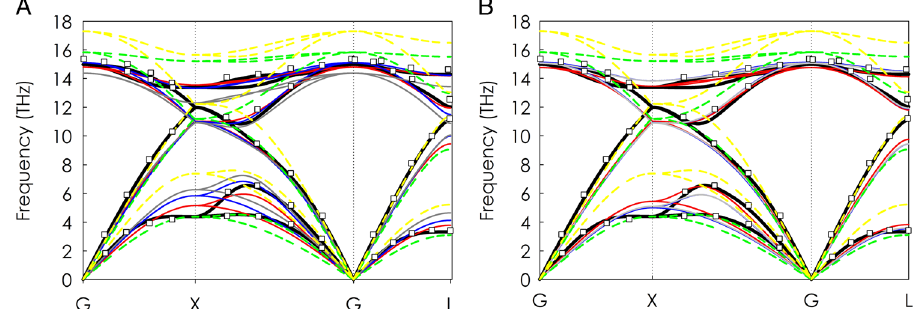
Fig. 6 DFT and experimental 42 phonon dispersion for Si, along with various POPs. The original Tersoff 17 and Stillinger – Weber 37 potentials are shown as yellow and green dotted lines , respectively. a DFT ( black ), TBC-1 ( red ), TBC-2 ( blue ), TBC-3 ( gray ) and experiments ( squares ) are shown. b DFT ( black ), M3BC-1 ( red ), M3BC-2 ( blue ), M3BC-3 ( gray ) and experiments ( squares ) are shown